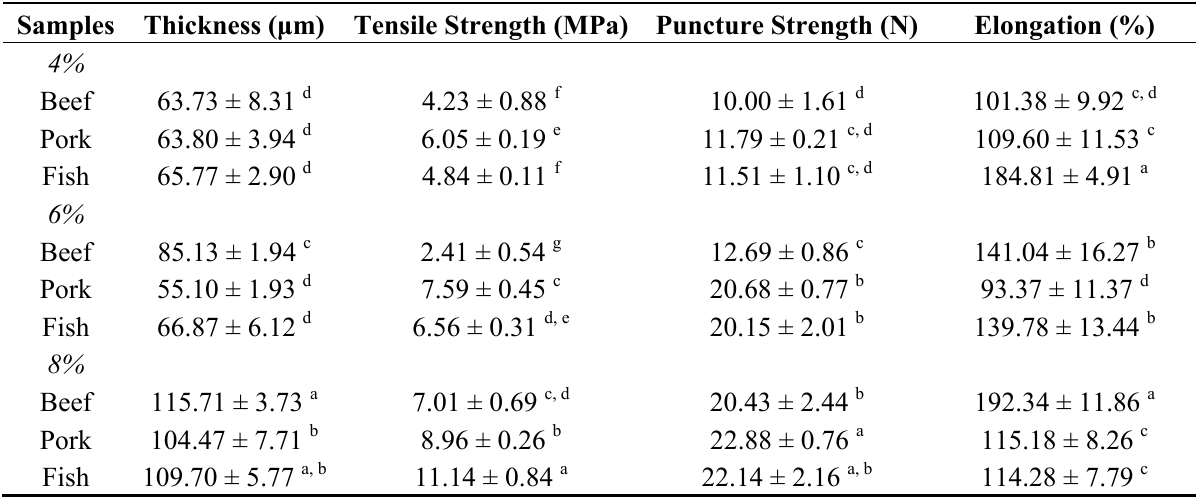
Table 1. Mechanical properties of gelatin films.